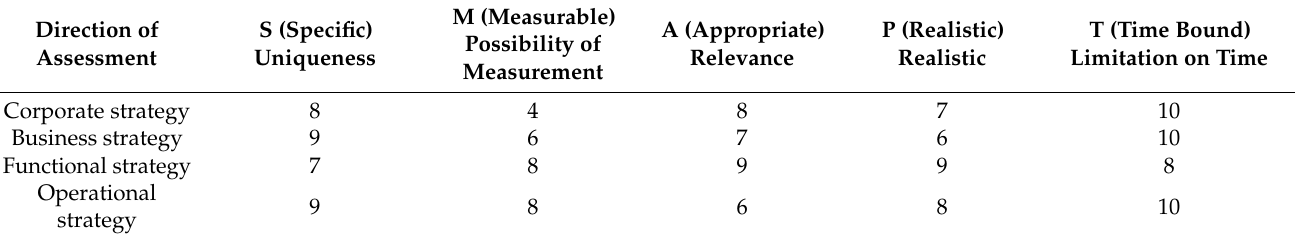
Table 3. Results of SMART-assessment of the goals of PJSC NOVATEK, maximum assessment—10 points. Direction